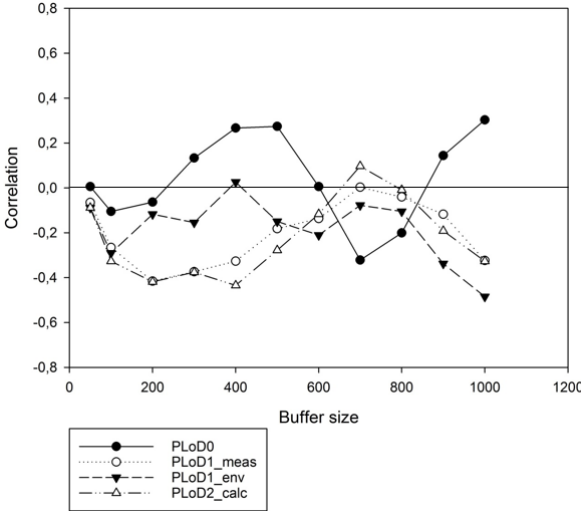
Figure 11. Correlation coefficients of the ‘porosity’ from LoD0 and LoD1 with different measures and measured TNC values in different buffer